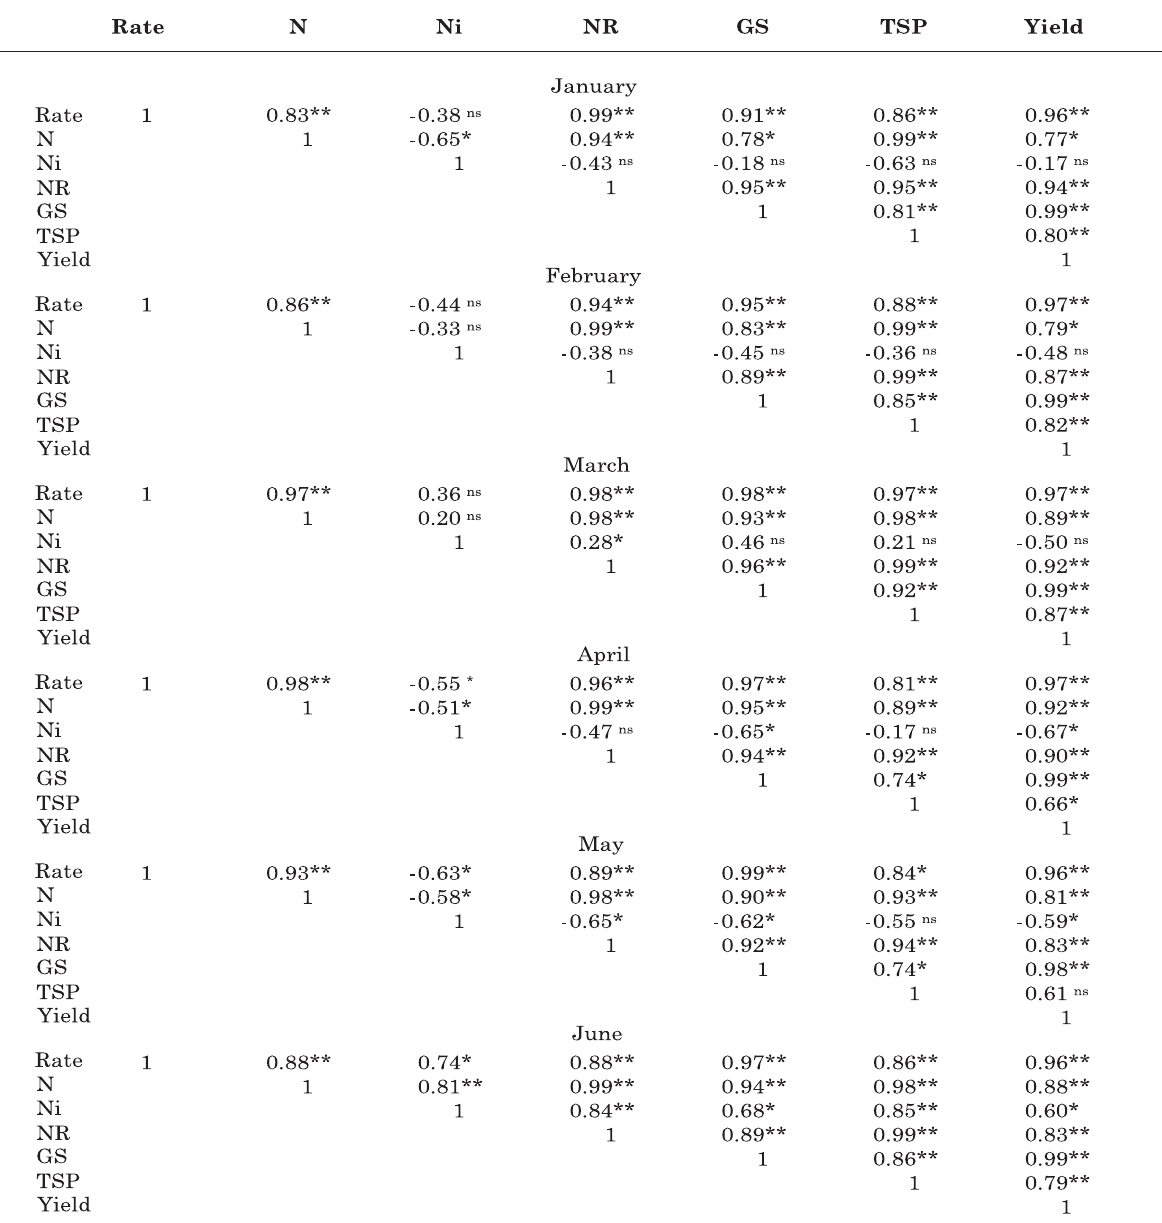
Table 2. Correlation between coffee yield, N-rates, leaf N and Ni concentrations, nitrate reductase (NR)